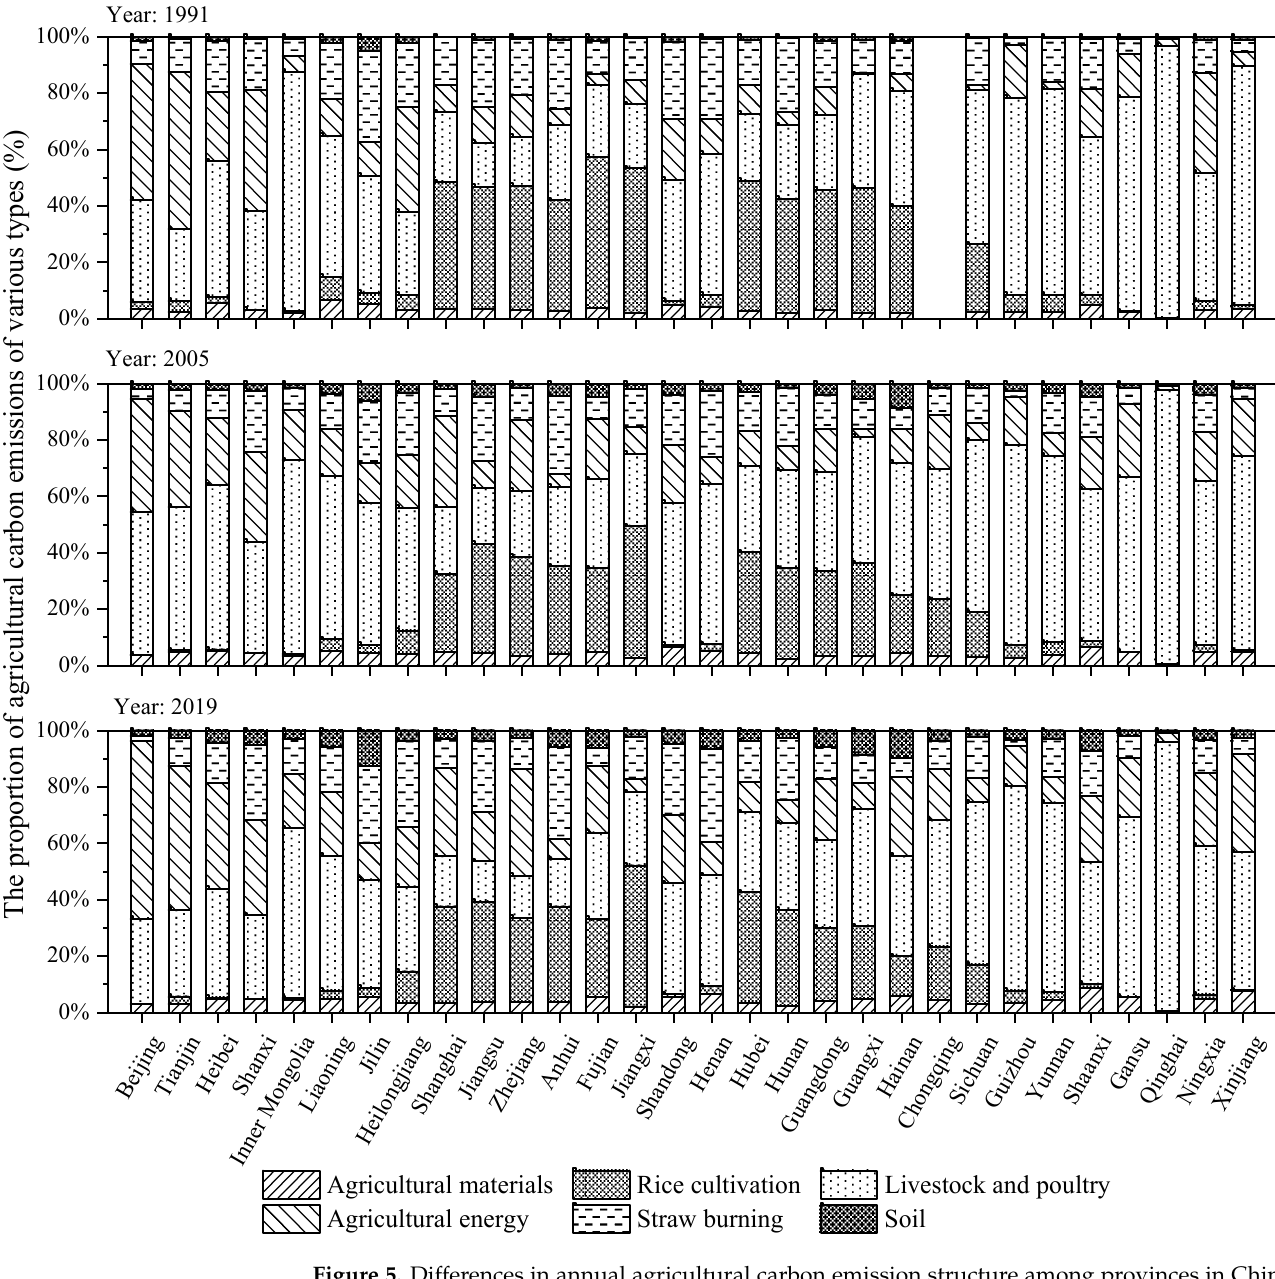
Figure 5. Differences in annual agricultural carbon emission structure among provinces in China, 1991–2019.